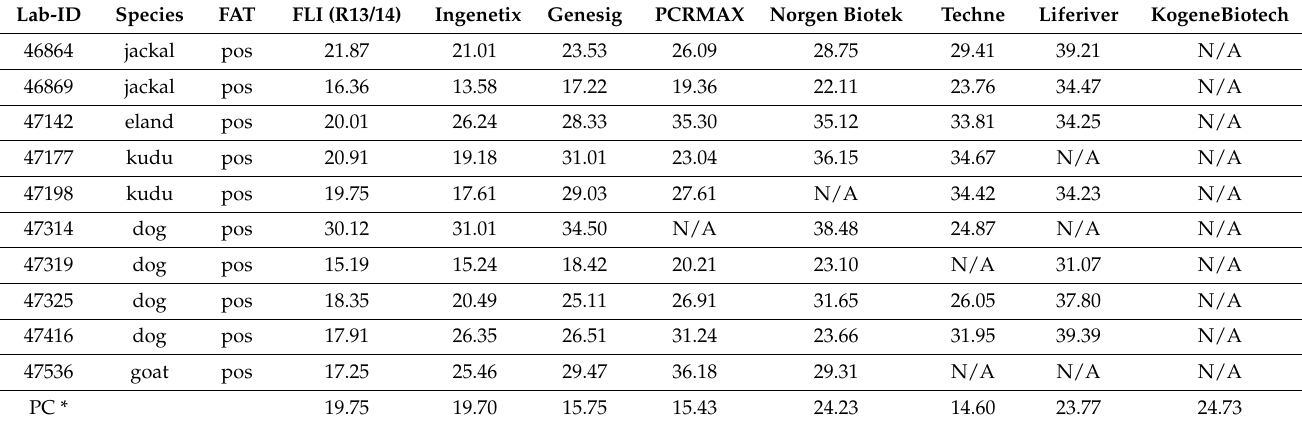
Table 3. Ct/cq values of the FLI RT-PCR (R13/14; Hoffmann et al., 2010, [14]) and commercial RT-PCRs for rabies applied on RNA from Namibian